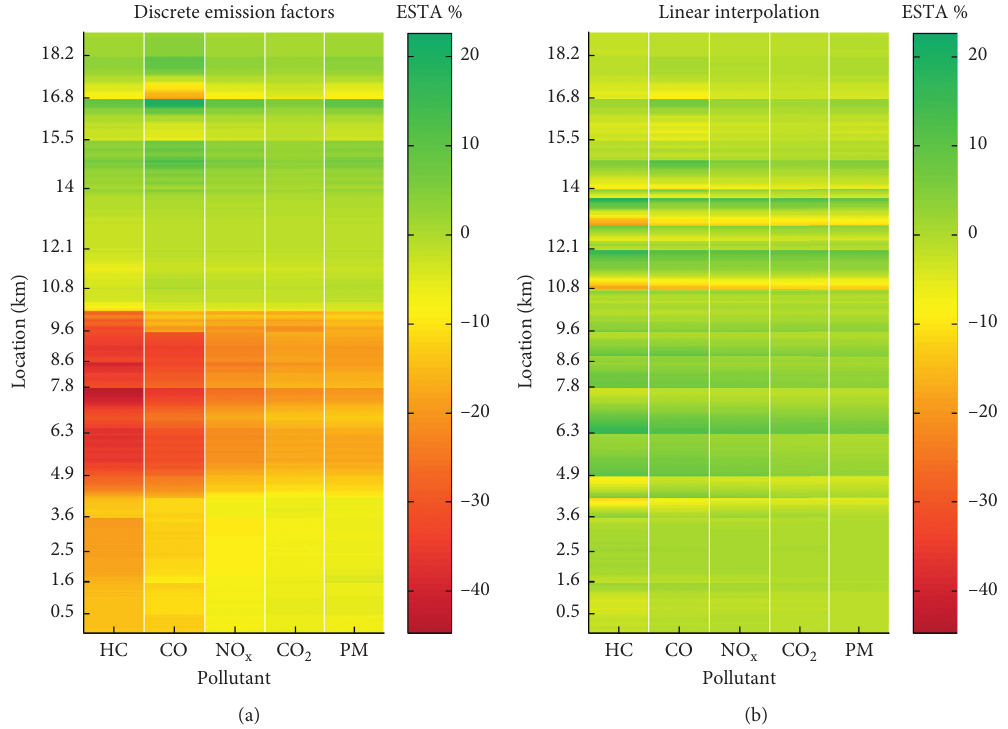
Figure 5: Average emission errors due to spatial and temporal aggregation (ESTA) when HBEFA emission factors are expressed as (a) discrete and (b) continuous functions of average speed.